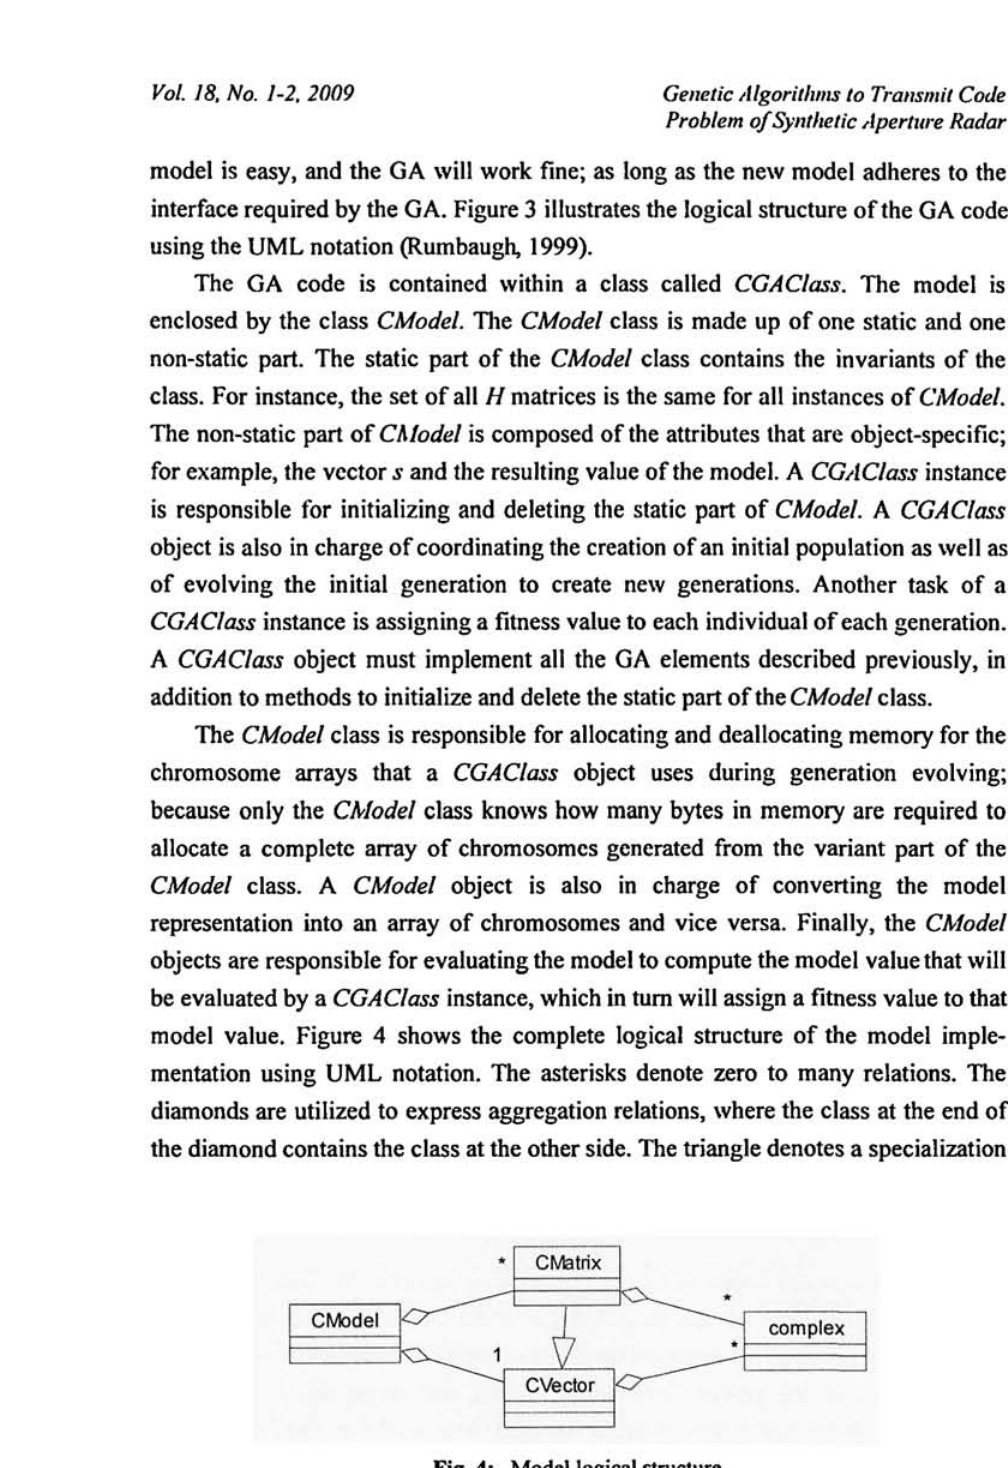
Fig. 4: Model logical